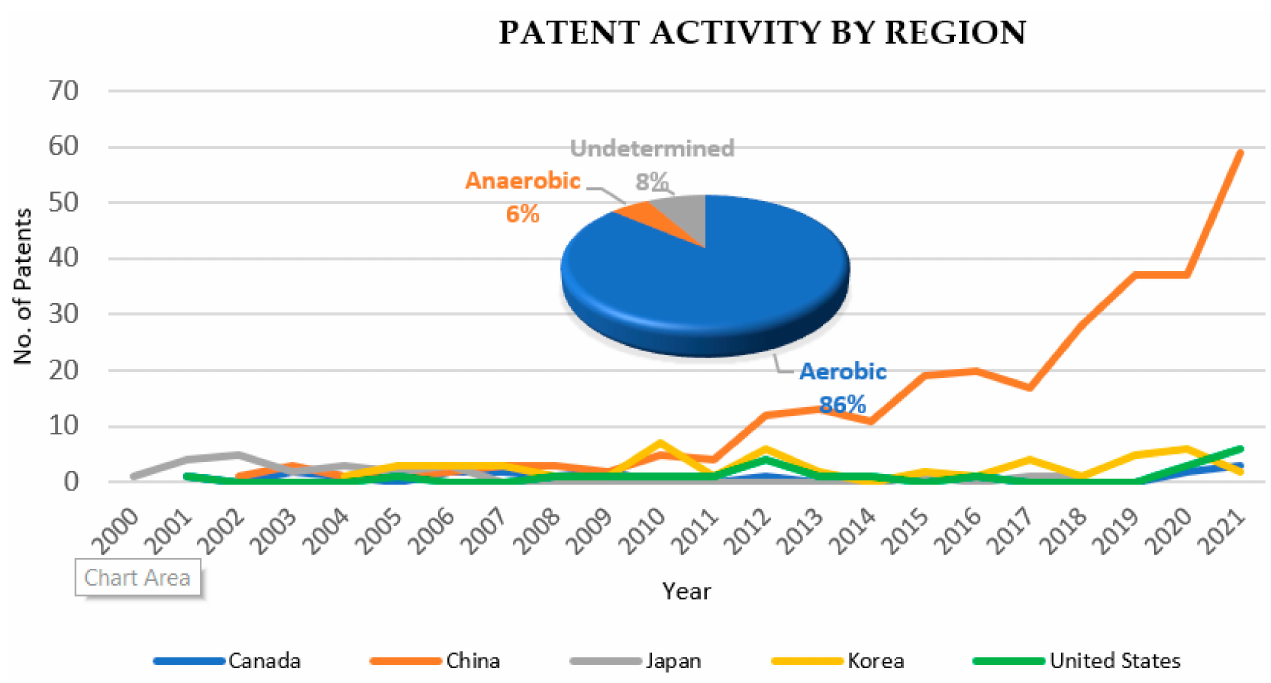
Figure 8. Patent activity by region and composting category